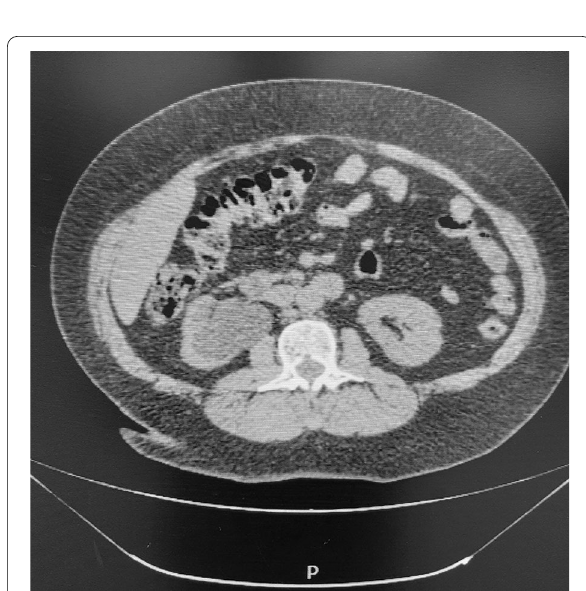
Fig. 4 Noncontrasted CT with right